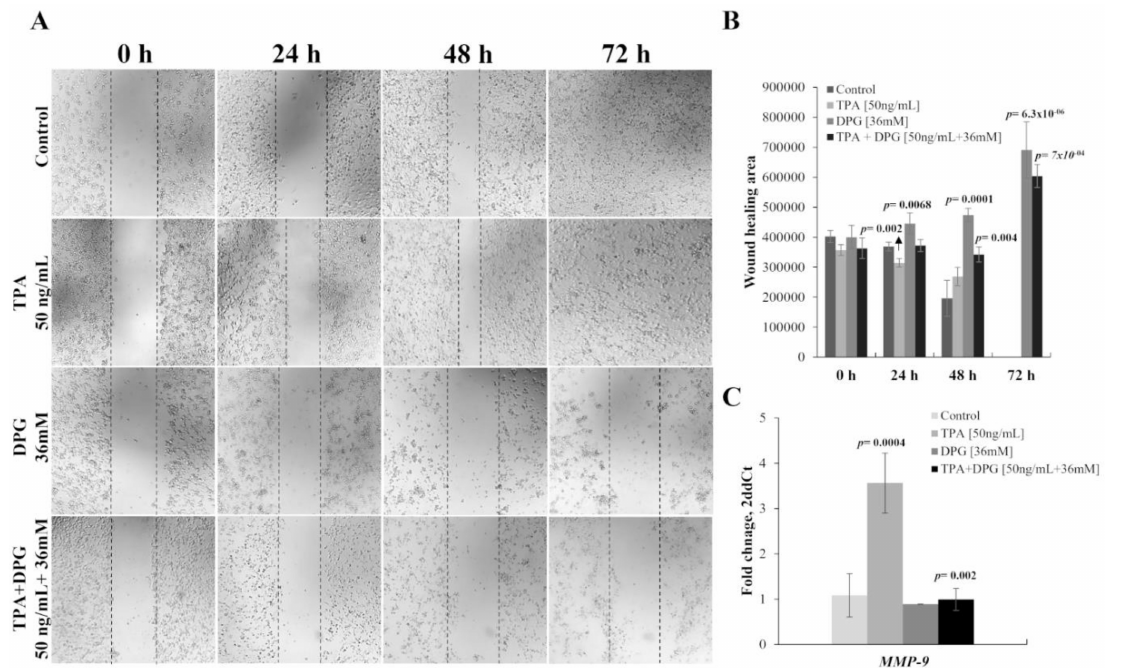
Figure 3. Melanoma cell migration stimulated by 12-O-tetradecanoylphorbol-13-acetate (TPA) was attenuated by adding dipotassium glycyrrhizinate (DPG) ( A ) TPA stimulates the migratory effect of SK-MEL-28 in a time-dependent trend, in comparison with untreated control cells. In contrast, DPG inhibits the migration of SK-MEL-28 in a time-dependent trend compared to untreated con- trol cells. Finally, SK-MEL-28 cell migration stimulated by TPA was attenuated by adding DPG. ( B ) A significant increase in the migration of SK-MEL-28 cells was observed in the presence of TPA stimulation for 24 h ( p -value = 0.002) and 48 h ( p -value = 0.09). Furthermore, migration of SK-MEL- 28 cells stimulated by TPA was attenuated by adding DPG cells by wound-healing assay (48 h: p -value = 0.004; 72 h: p -value = 7.0 × 10 − 4 ). ( C ) An increased Matrix Metalloproteinase 9 ( MMP-9 ) mRNA expression level was observed compared to control cells SK-MEL-28 cells stimulated by TPA ( p -value = 0.0004). Otherwise, decreased MMP-9 expression was observed in those DPG-treated